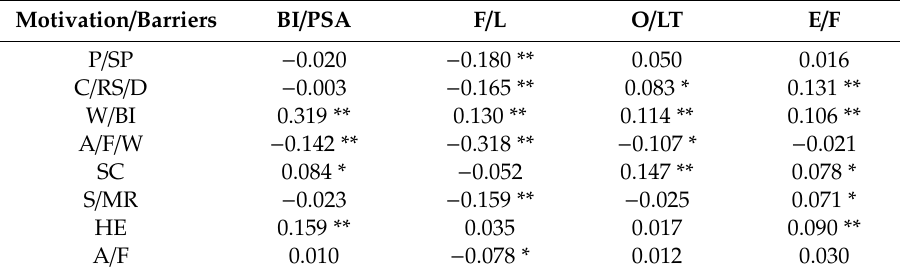
Table 3. Correlation coe ffi cients between the factors that make up the motivation and the barriers to the practice of physical